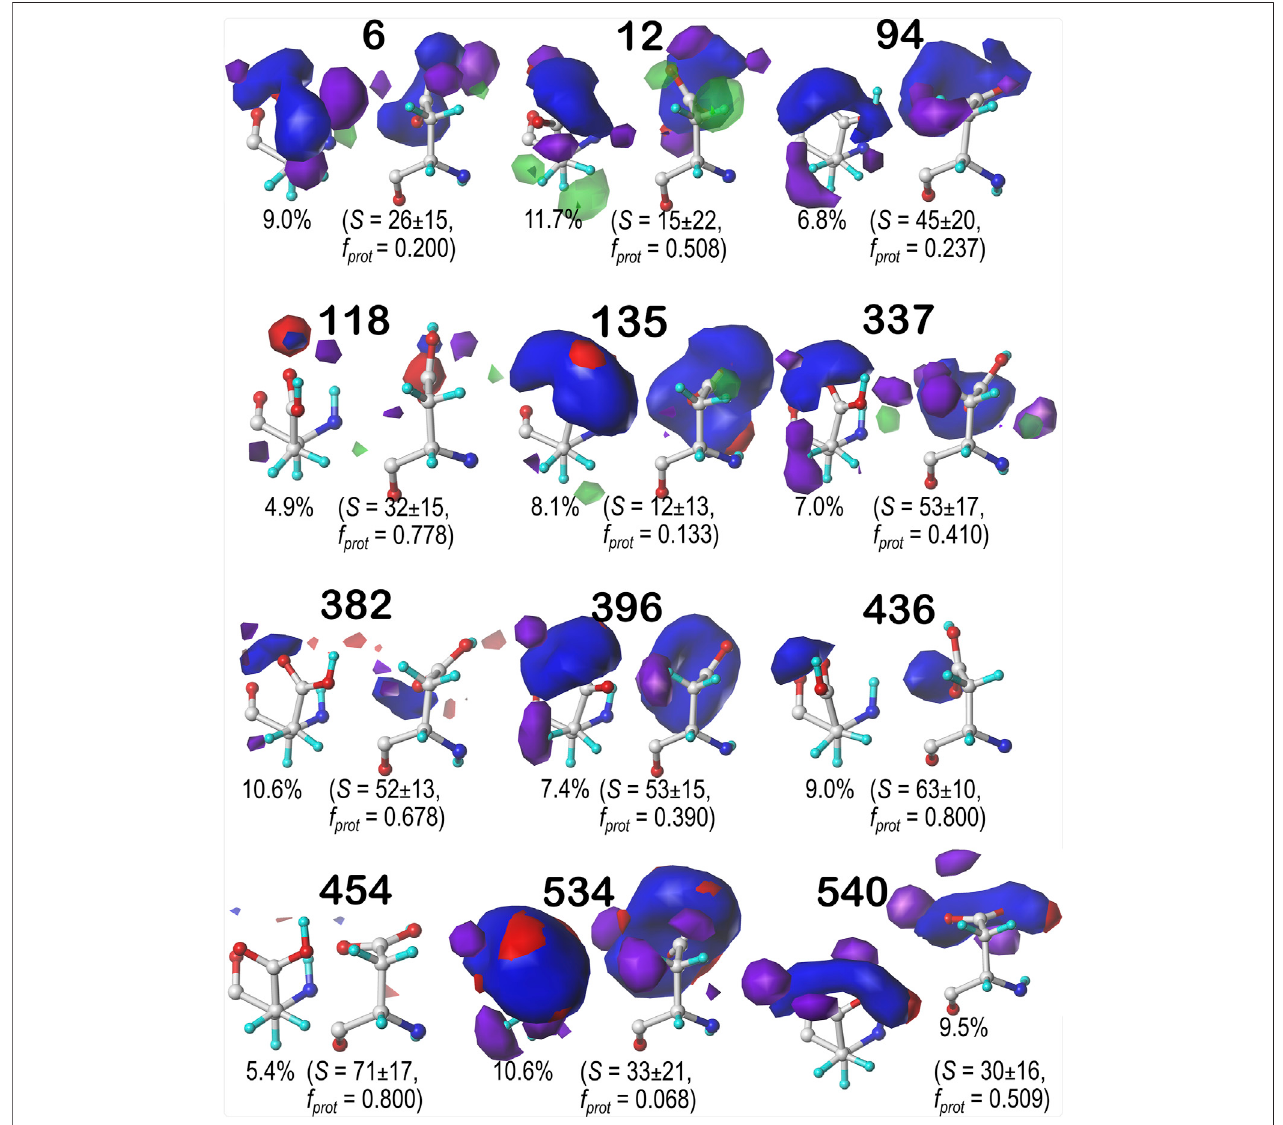
FIGURE7| Hydropathic interactionmaps displaying the Gaussian-weightedaverage sidechainenvironments ofaspartic acidin the χ 1 (cid:1) 60 ° parse ofthe b1 chess square at pH (cid:1) 3.345. Two map viewpoints are given for each cluster, whose ID is given in bold. The left map in each pair is oriented such that the CA-CB z-axis bond points upward, while the right is oriented to point it out of the page. The x-axis is oriented horizontally in both. The percentage indicates the fraction of the parse represented by that cluster. S represents the solvent accessible surface area in Å 2 , and f prot indicates the fraction of the cluster protonated at pH 50 . Blue contours indicate positive polar interactions made with the sidechain, and red indicates negative polar interactions, while green and purple indicate positive and negative hydrophobic interactions, respectively.